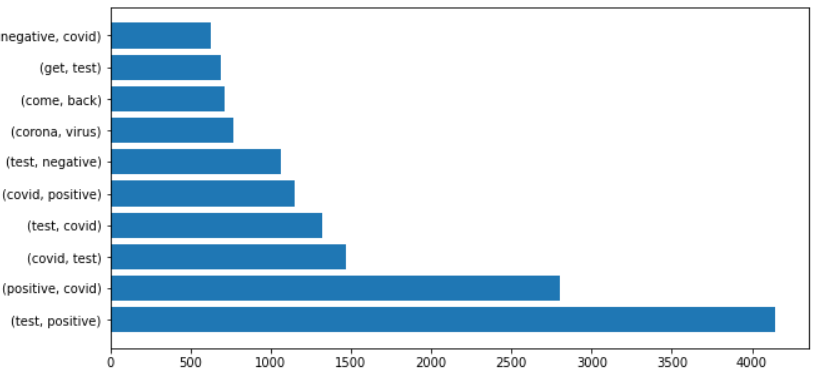
Figure 5. Most frequent bi-grams in the